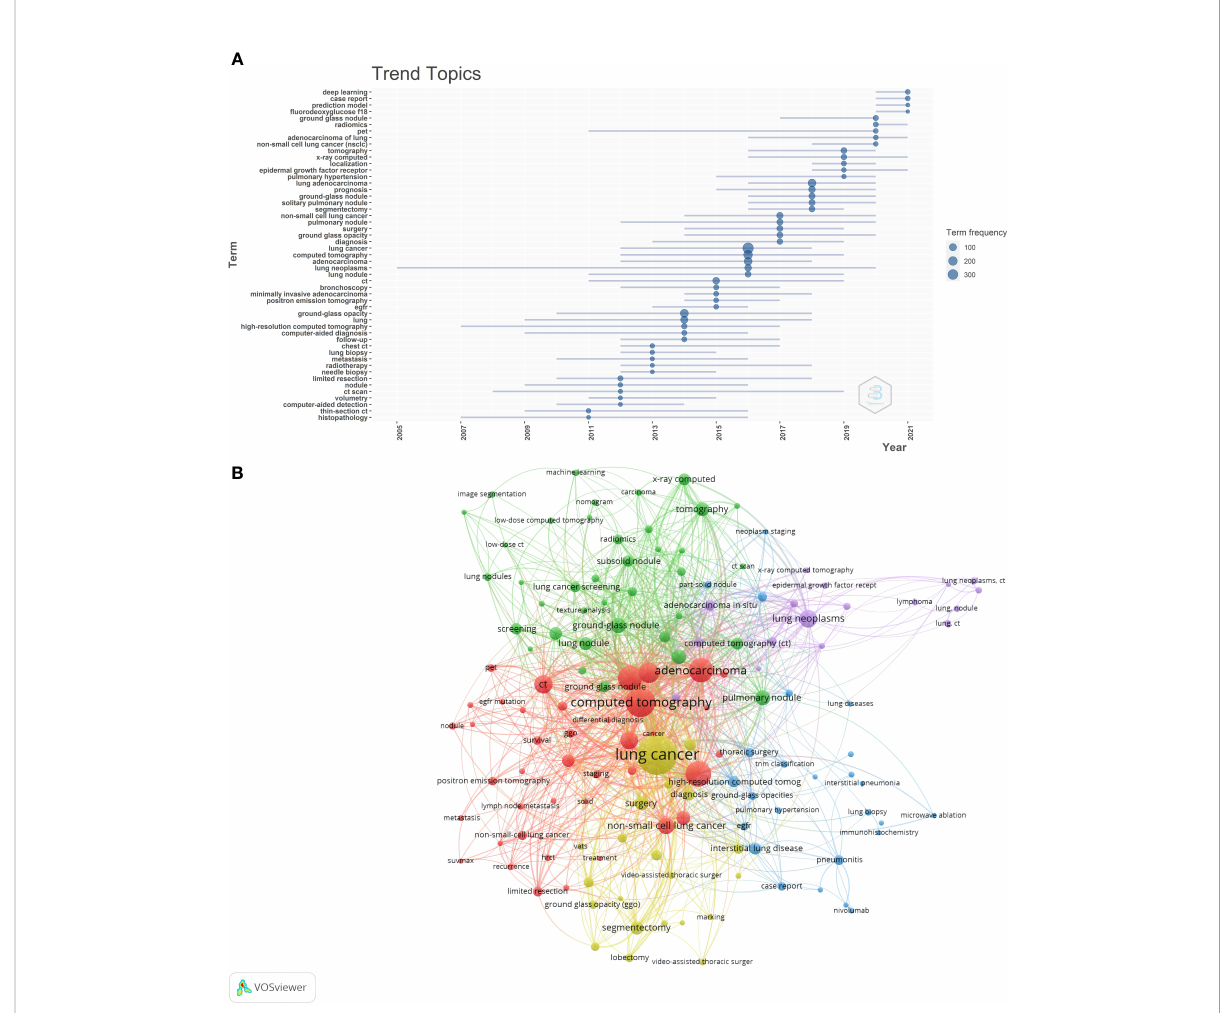
FIGURE 4 (A) The graph shows the change over time of the most frequent keywords in each year, with the size of the blue nodes representing the frequency of keyword occurrences. (B) This is the cluster analysis map of keywords. The size of the dot represents the frequency of keyword occurrence, and the color of the dot represents the keyword